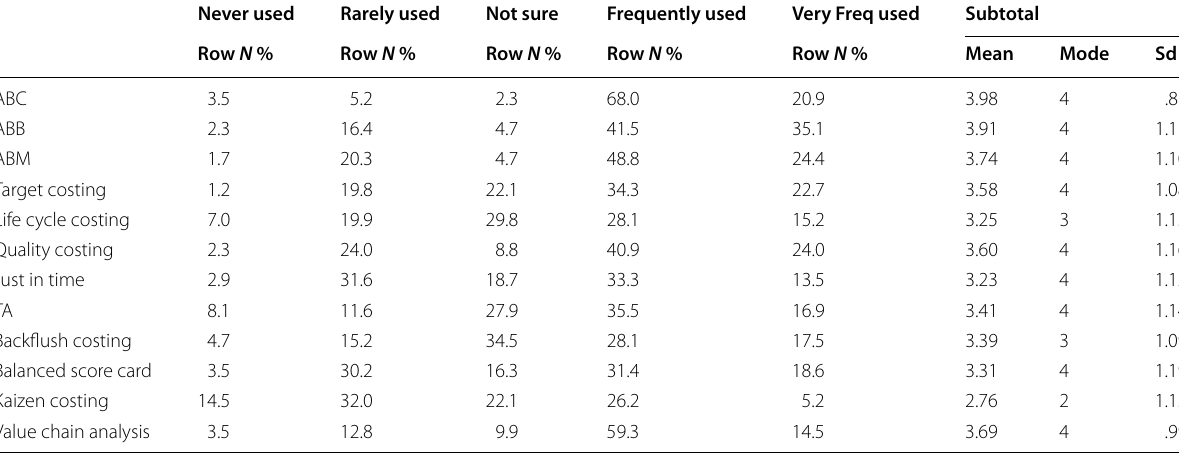
Table 1 Descriptive statistics for management accounting